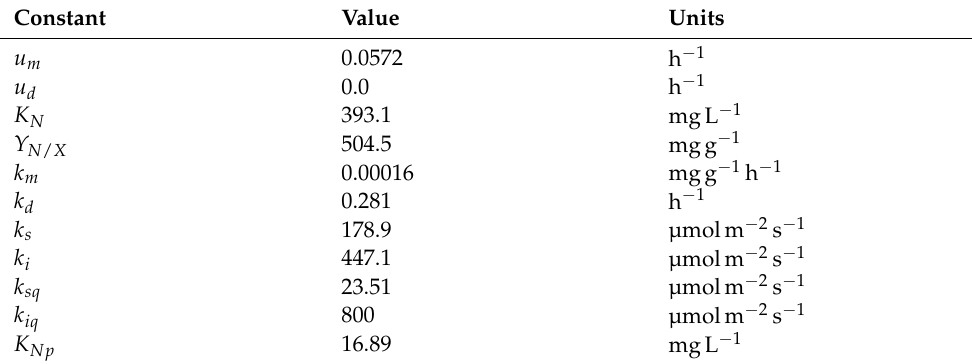
Table A3. Parameter values for plant.